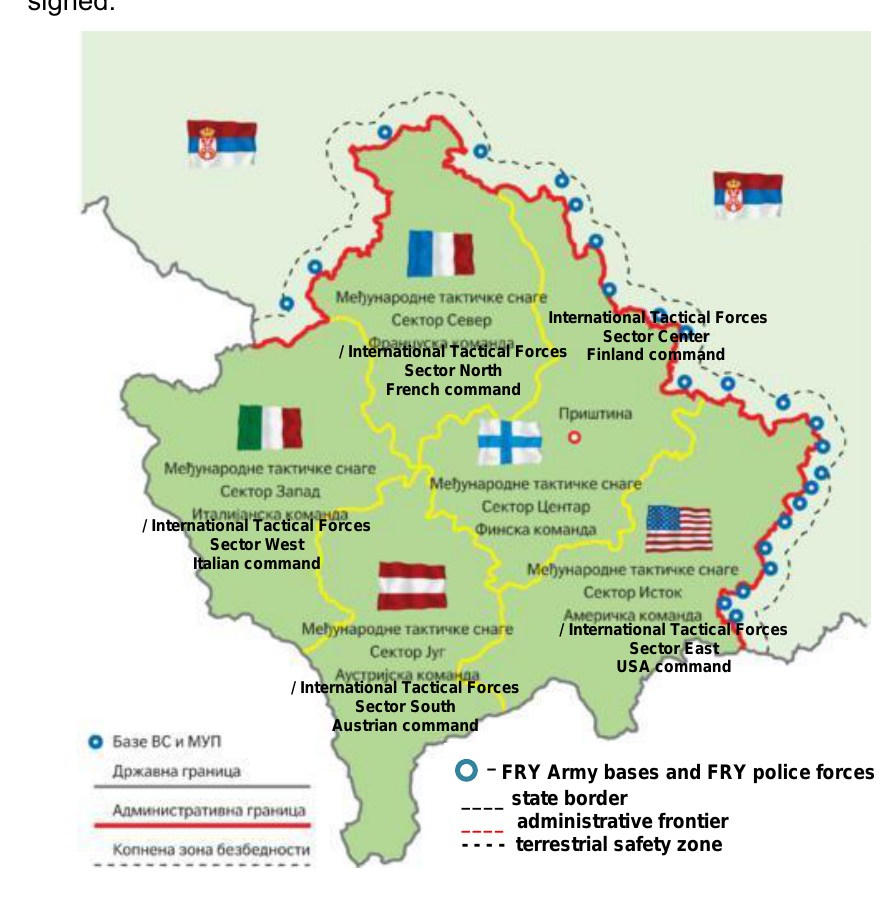
Figure 3 – Deployment of international forces after the signing of the